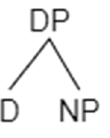
Figure 12. DP structure.